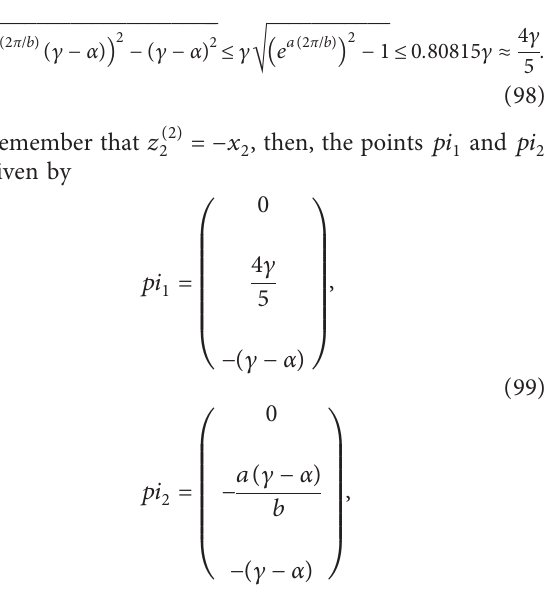
Figure 10: Projection of the manifolds on (a) x solid lines, respectively, the switching surfaces with green